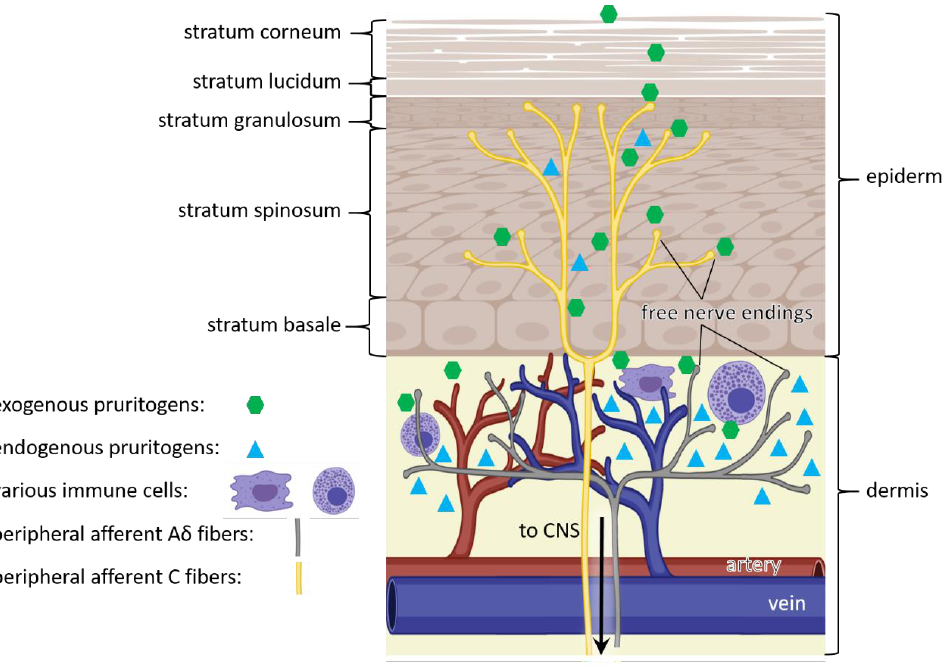
Figure 1. Pathway of itch. Itch sensation is caused by exogenous (green) and endogenous (cyan) pruritogens, that bind to itch receptors in free nerve endings of C fibers within the epidermis (yellow) and Aδ fibers within the dermis (grey). In addition, endogenous pruritogens (cyan) can be produced by epidermal keratinocytes and dermal immune cells (purple). The triggered signal is transmitted through peripheral afferent nerve fibers (yellow and grey) of the peripheral nervous system to the central nervous system (CNS), eventually resulting in itch sensation. (Figure adapted from [28]).